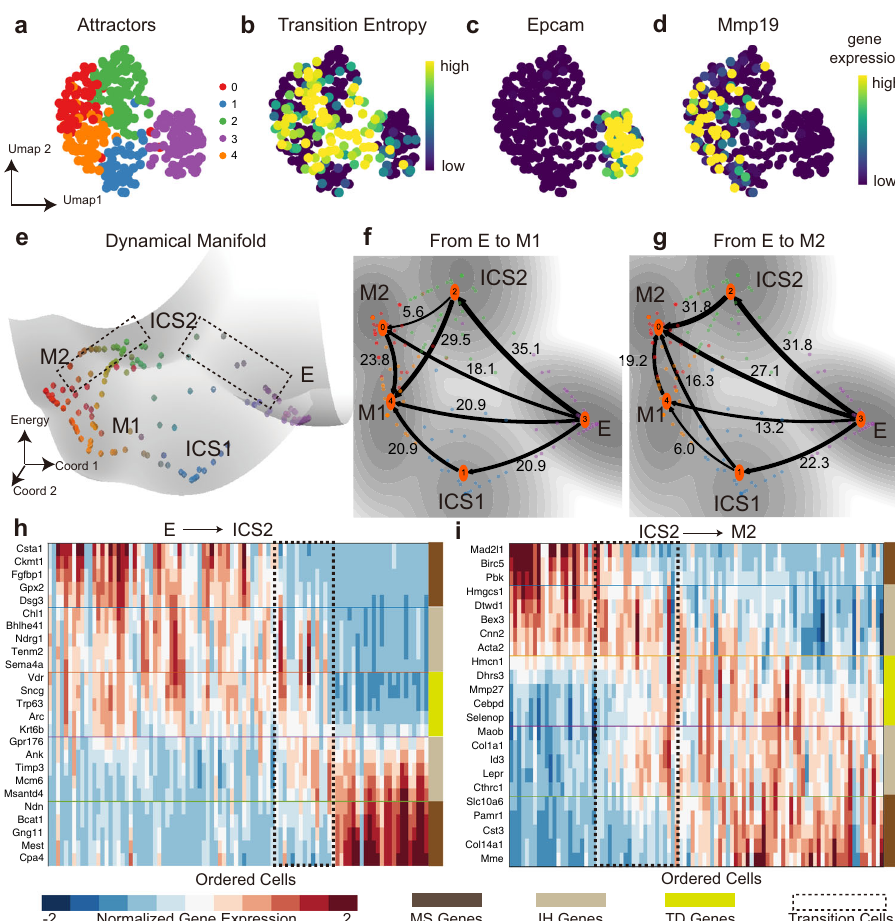
Fig. 3 MuTrans reveals the cell-state transitions in EMT dataset of Squamous Cell Carcinoma. a Attractor basins found by MuTrans, with cells plotted in the UMAP low-dimensional space and colored by MuTrans attractors. b Calculated transition entropy of each cell, with larger values corresponding to more intermediate cells with highly mixing identities. c , d Gene expression value of epithelial state (E) marker Epcam and mesenchymal state (M) marker Mmp19. e The dynamical manifold of EMT with cells colored by MuTrans attractors in ( a ). Two dashed squares indicate the transition processes presented in ( h ) and ( i ). Attractor 0 is annotated as the epithelial (E) state, attractor 0 and 4 as two mesenchymal (M) states, and attractor 1 and 2 as two intermediate cell states (ICS) of EMT. f , g The transition path analysis by setting E attractor as start state and two M attractors as target state, respectively, overlaid on the dynamical manifold. The numbers indicate the relative likelihood of each transition path. The cells are colored by MuTrans attractors. The grayness indicates energy values of dynamical manifold, with darker colors representing lower energy values. h , i Transition cells and genes analysis during the transitions from E to ICS2 ( h ) and from ICS2 to M2 ( i ). For each cell-state transition, the cells (columns) of heatmap are ordered by transition cell scores (TCS) of each process, and transition cells marked by the black dashed rectangles. The rows of heatmap are the top fi ve most signi fi cant genes identi fi ed for the down-regulated MS (meta-stable) genes, down-regulated IH (intermediate-hybrid) genes, TD (transition-driver) genes, up-regulated IH genes and up-regulated MS genes, respectively (from top to bottom in (Fig. 5c, yellow lines), we also detected the up-regulated IH genes (Fig. 5c, yellow lines), suggesting the resemblance of transition cells with their targeting gran cell state (Supplementary Table 5).